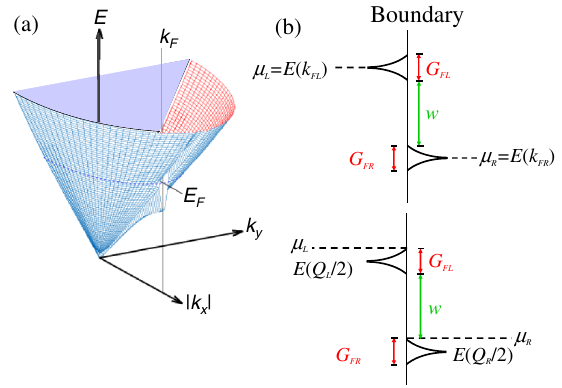
FIG. 1 (color online). (a) Schematic illustration of the Friedel gap at E F for wave vectors perpendicular to an interface, assuming a linear unperturbed dispersion (e.g., that of graphene). (b) Schematics showing the Friedel gap shifting on two sides of an interface. Upper panel: Friedel gaps open at the respective chemical potentials, without considering the nonequilibrium effect of Friedel gap shifting. Lower panel: Both gaps completely exist below their respective chemical